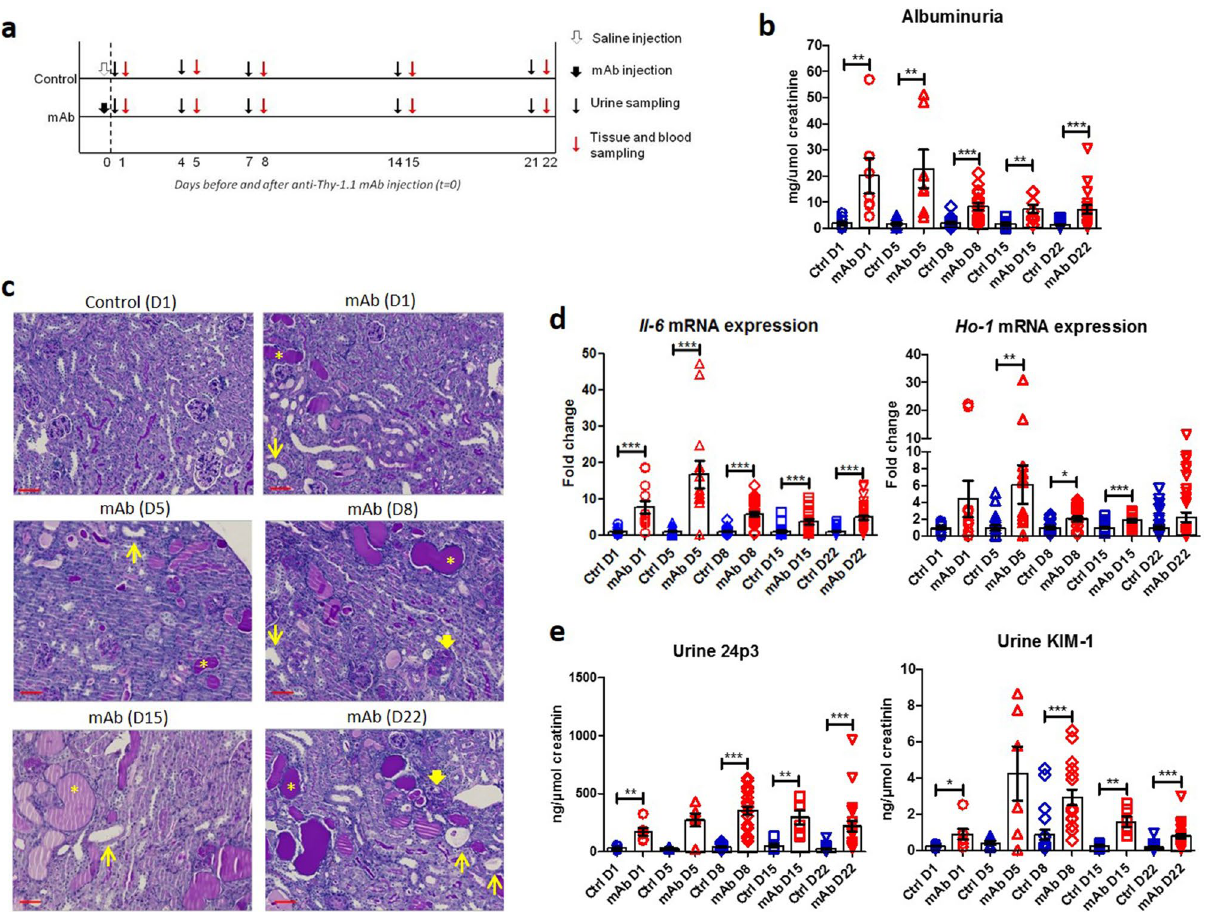
Figure 1. Progressive kidney injury in Thy-1.1 mice after mAb injection. Schematic overview of the experimental setup ( a ); transgenic Thy-1.1 mice were injected with anti-Thy-1.1 antibody (mAb) or saline as control (Ctrl) and sacrificed at the indicated time points after 24 h urine collection. Injection of mAb resulted in significantly increased albuminuria compared to control at all time points ( b ). Representative images of kidney PAS staining show progressive kidney injury in mAb-injected mice characterized by tubule dilatation (narrow arrows) and loss of brush border, proteinuric cast formation (asterisks) and glomerular sclerosis (thick arrows) ( c ). Kidney mRNA expression level of Il-6 and Ho-1 ( d ) and urine excretion of kidney injury markers 24p3 and KIM-1 ( e ), demonstrate significant kidney injury in mAb-injected mice compared to control. *p < 0.05, **p < 0.01, ***p < 0.001 compared to control using Mann–Whitney t-test; D day, Ctrl control, mAb monoclonal antibody. Scalebar = 50